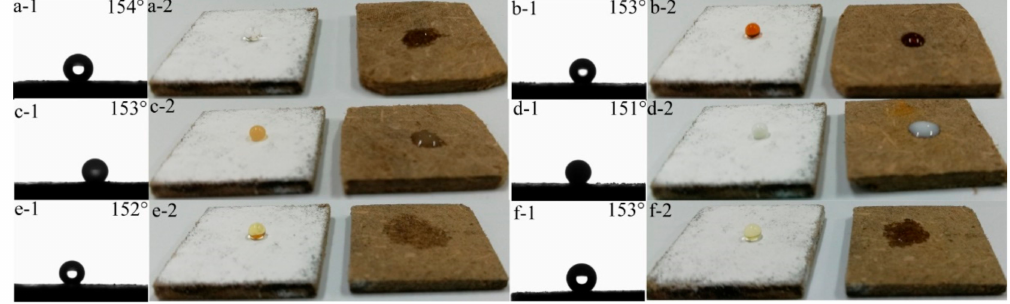
Figure 6. Images of different liquids on the surface of LC and LC coated with PDMS@STA-KL: ( a-1,a-2 ) tea; ( b-1,b-2 ) soy sauce; ( c-1,c-2 ) coffee; ( d-1,d-2 ) milk; ( e-1,e-2 ) millet wine; ( f-1,f-2 )